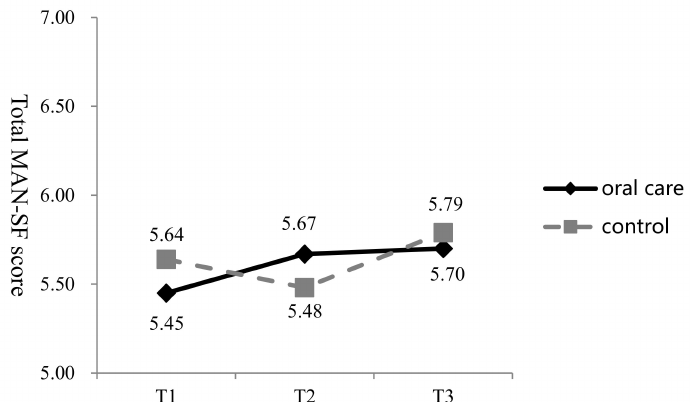
Figure 4. Change in the Mini-Nutritional Assessment-Short Form (MNA-SF) scores in the two groups at three time points